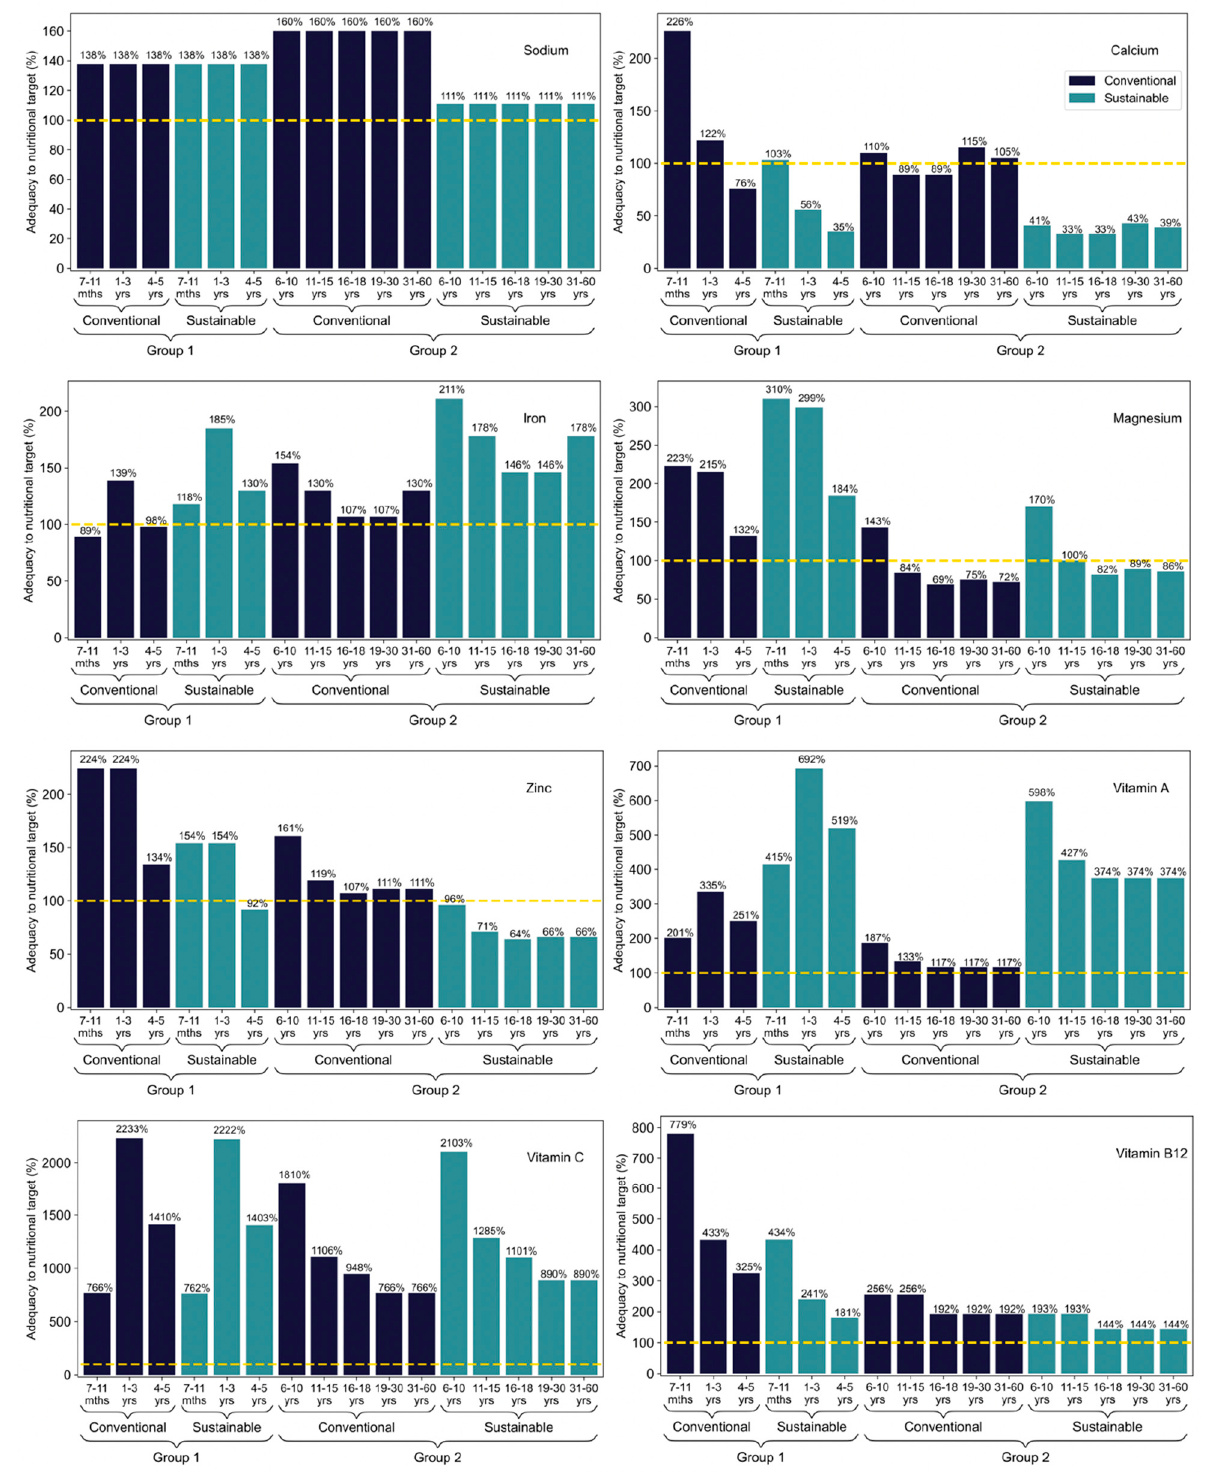
Figure 3. Micronutrients adequacy of conventional and sustainable menus to nutritional targets, according to the age group. Age groups considered were from 7 months to 60 years old, for both school food menus. Yellow dashed line represents the national daily nutritional recommendation for school meals (Group 1 is 70%, and Group 2 is 30% of the daily intake). For sodium, the daily nutritional recommendation refers to a maximum level. N/A means no official recommendations for this age group. Mths and yrs on the X axis mean months and years, respectively.